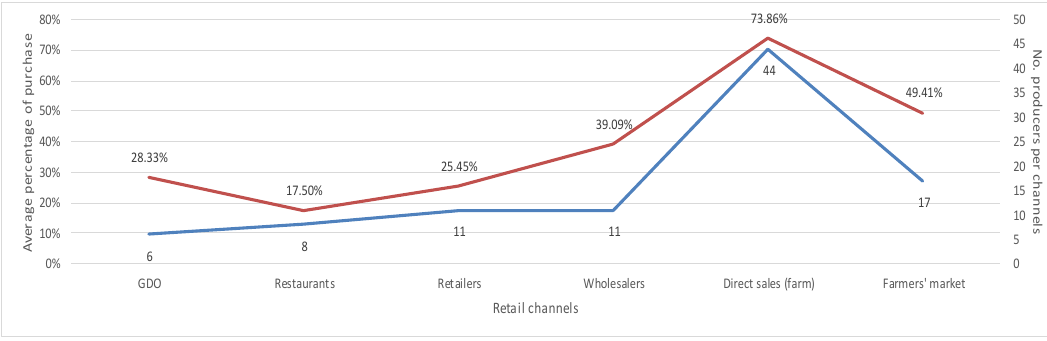
Figure 1. Retail channels and percentage of purchase of traditional cheeses.